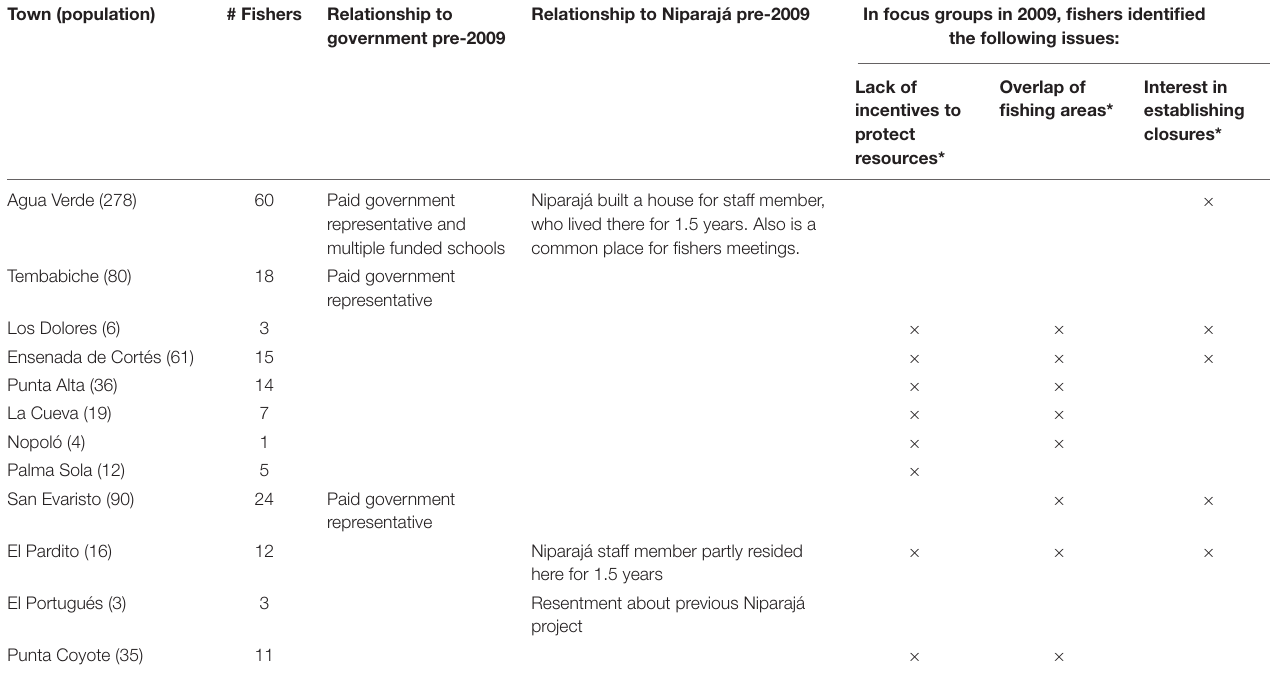
TABLE 1 | Comparison of fishing towns in El Corredor in terms of total population, number of commercial fishers, relationship to government prior to 2009, relationship with Niparajá prior to 2009, accessibility through roads, lack of incentives to take care of fishing areas, conflicts with other fishers due to fishing areas overlap, and whether or not they proposed an area